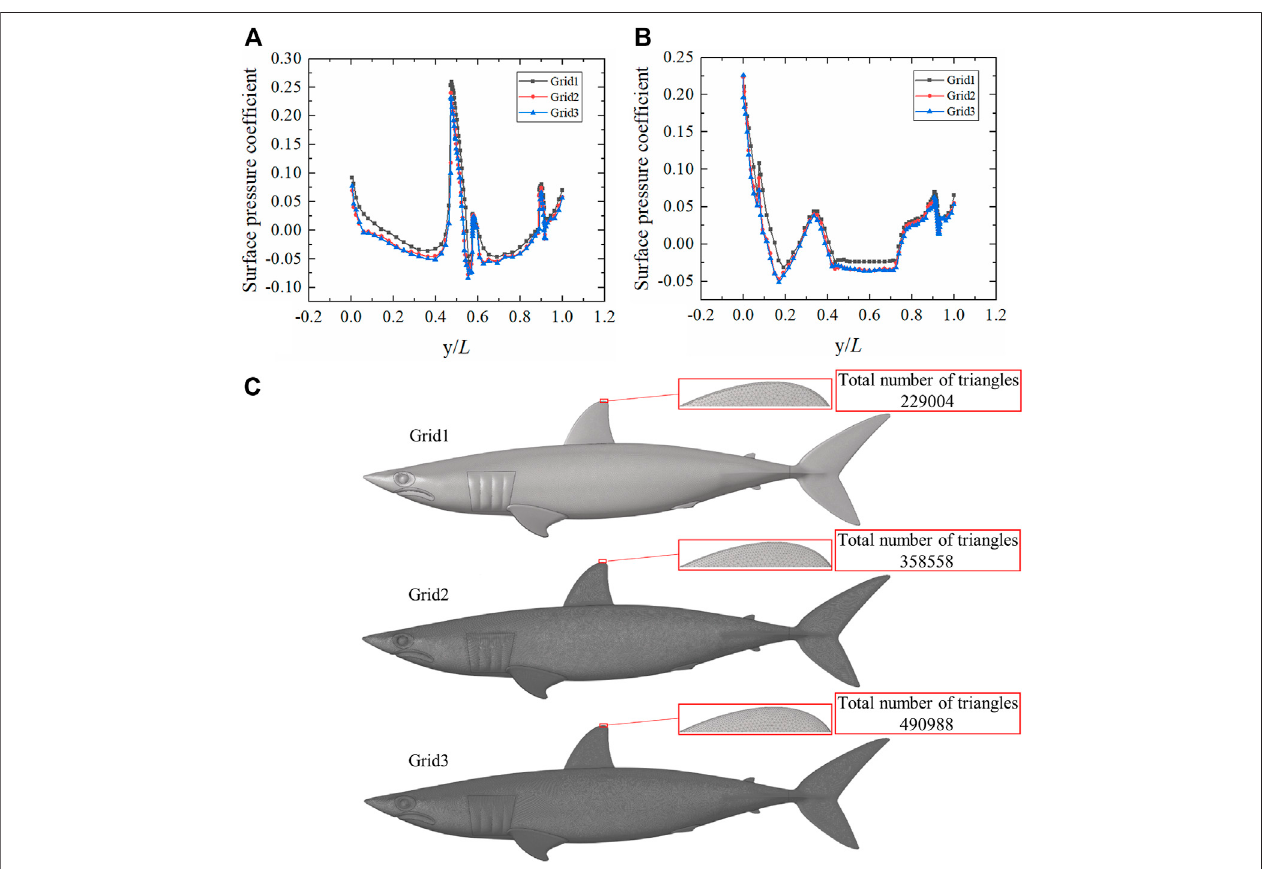
FIGURE 2 | Grid independence analysis of smooth shark model. (A) Comparison of surface pressure coef fi cients on the upper surface of the smooth shark model forthethree gridschemes. (B) Comparison ofsurface pressurecoef fi cientsonthelowersurface ofthesmoothsharkmodelforthethreegrid schemes.y/Listheratioof the position coordinate to the length of the shark. (C) Smooth shark model surface grids. The total number of triangles are displayed in the upper right corner.